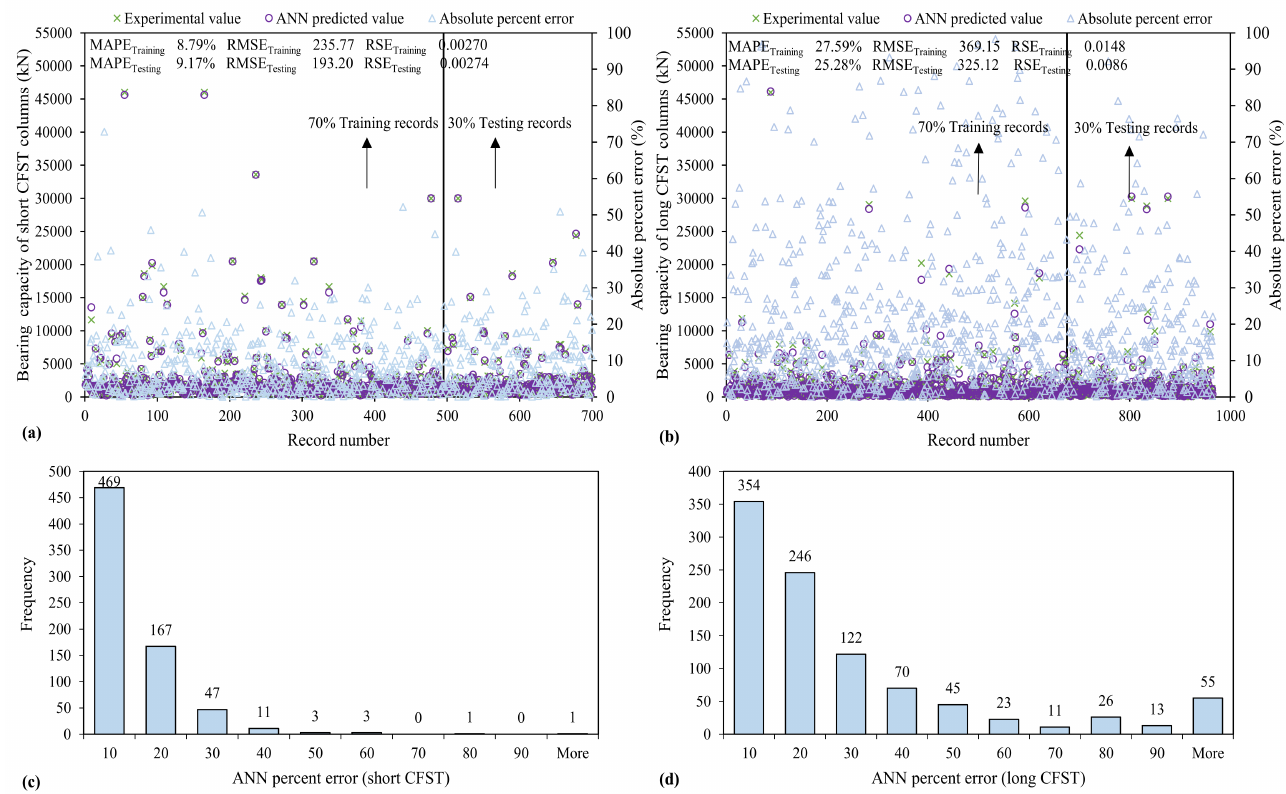
Figure 7. Variation of mean absolute error and error histograms of bearing capacity established using ANN algorithm ( a , c ) short CFST ( b , d ) long CFST